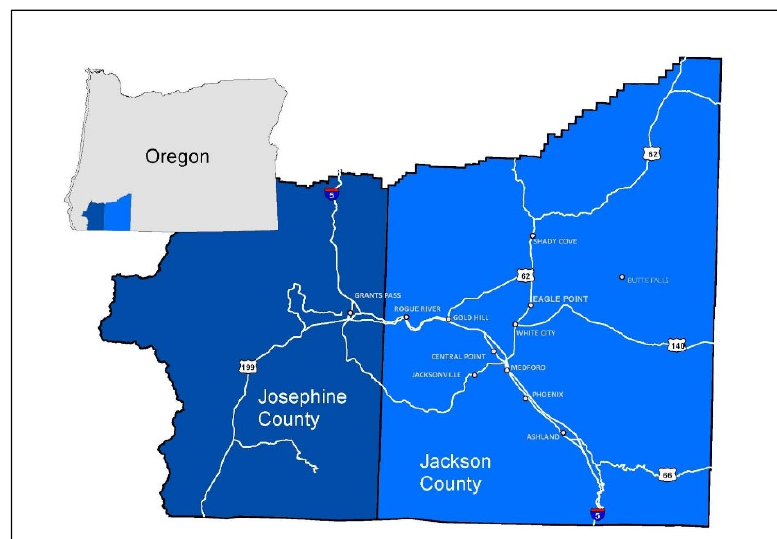
Figure 1. Southern Oregon’s Rogue Valley (Jackson and Josephine